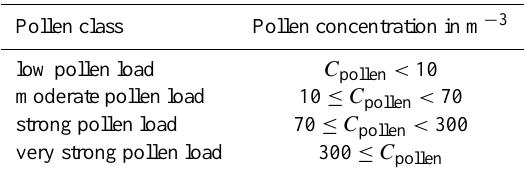
Table 1. Sites of the pollen measurements and their geographical locations, numbers refer to the numbering in the figures and tables of Sect. 6.